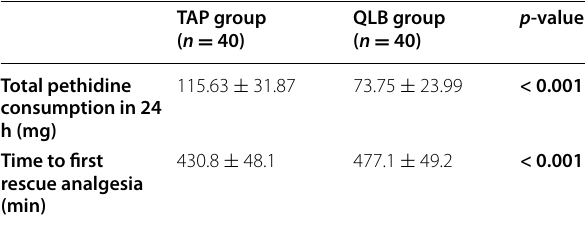
Table 3 Difference between TAP group and QLB group regarding total pethidine consumption in 24 h (mg) and time to